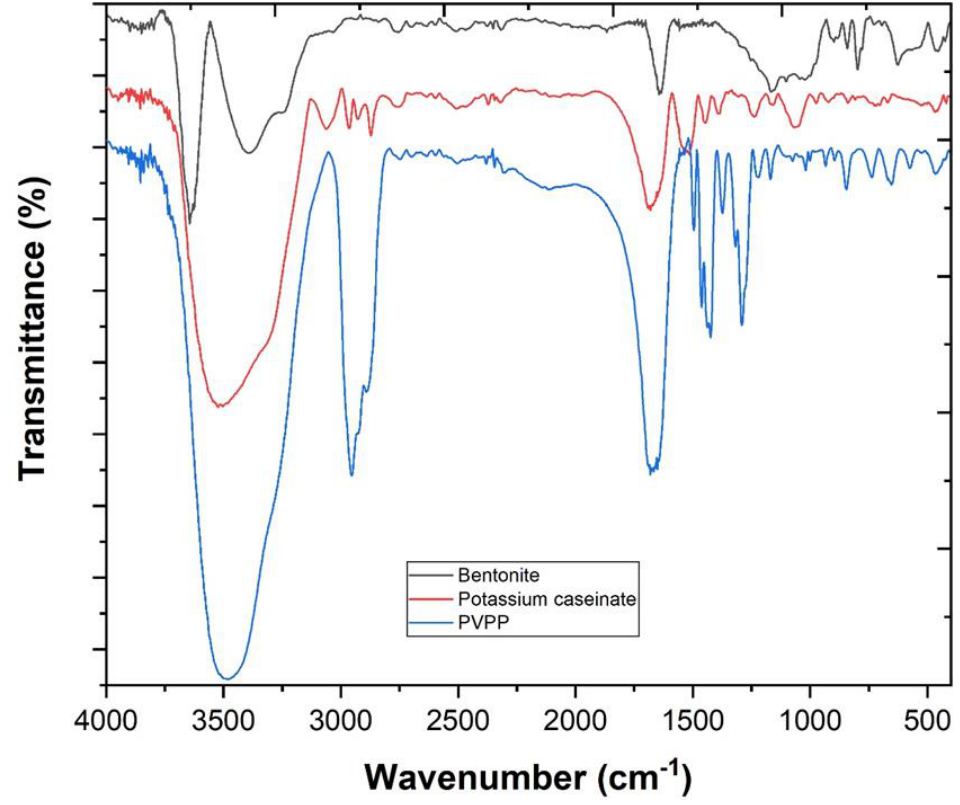
Figure 1. FTIR spectra of bentonite, potassium caseinate and PVPP. Table 4. Specific surface areas and pore characteristics of coagulants (n.q.—not quantifiable). Coagulants S BET (m 2 /g) V total pore (cm 3 /g) Particle Size (nm) Activated sodium bentonite 8.8 0.045 4.0 Potassium caseinate 1.0 PVPP